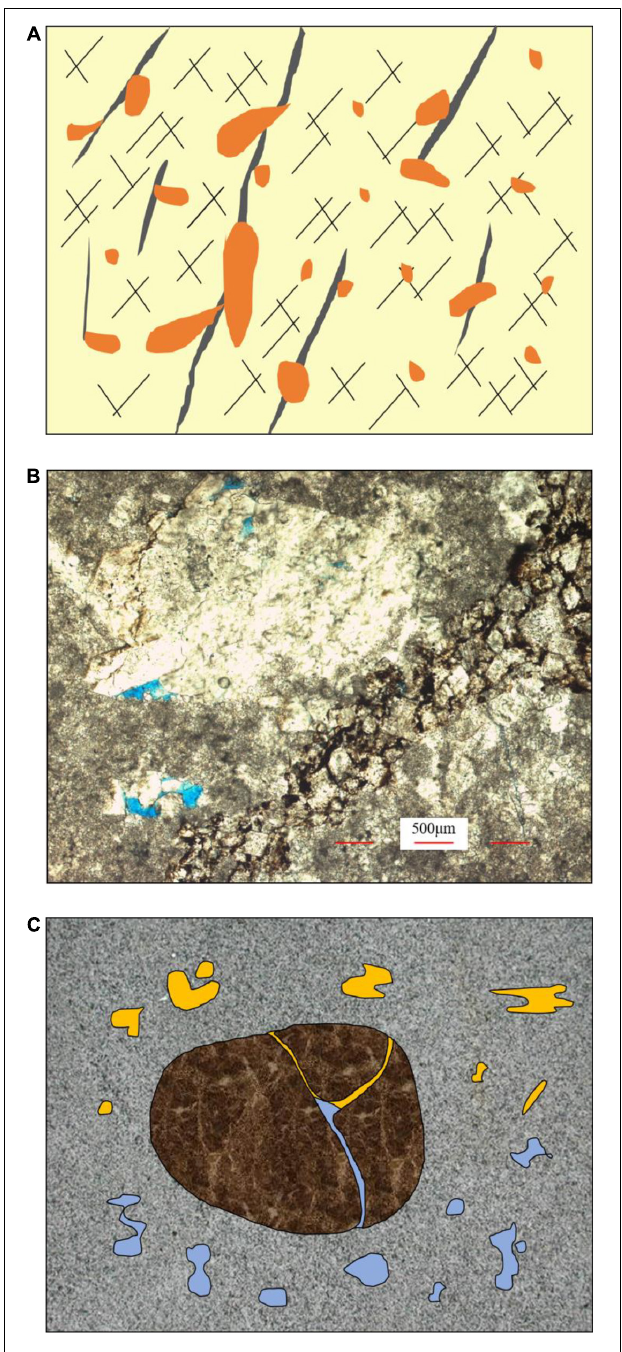
FIGURE 1 | (A) Schematic of a fault-controlled karst reservoir (orange represents caverns and vugs, while black refers to cracks); (B) thin section of a carbonate sample; (C) schematic of a double-porosity structure with patchy saturation of fluids (two skeletons and two fluids; orange represents oil and blue is